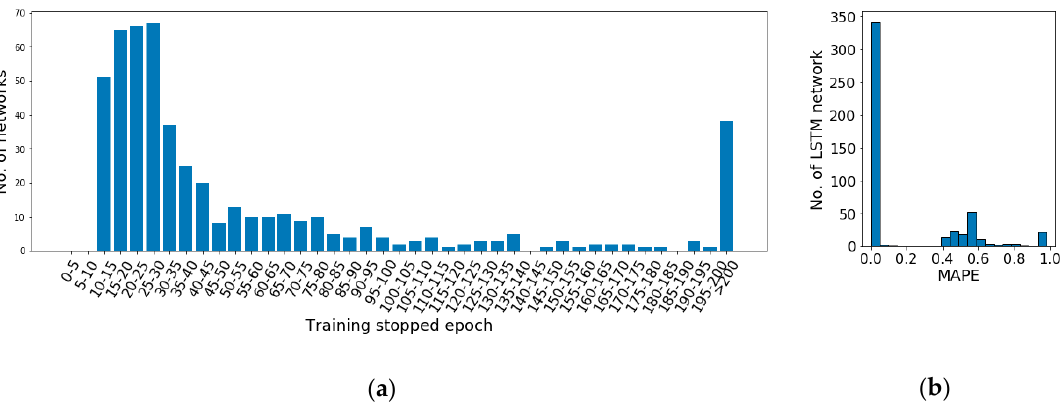
Figure 6. The performance of 500 random initialized networks which are randomly generated using the potential network configuration set: ( a ) Distribution of training stopping epochs; ( b ) Distribution of performance of the networks.